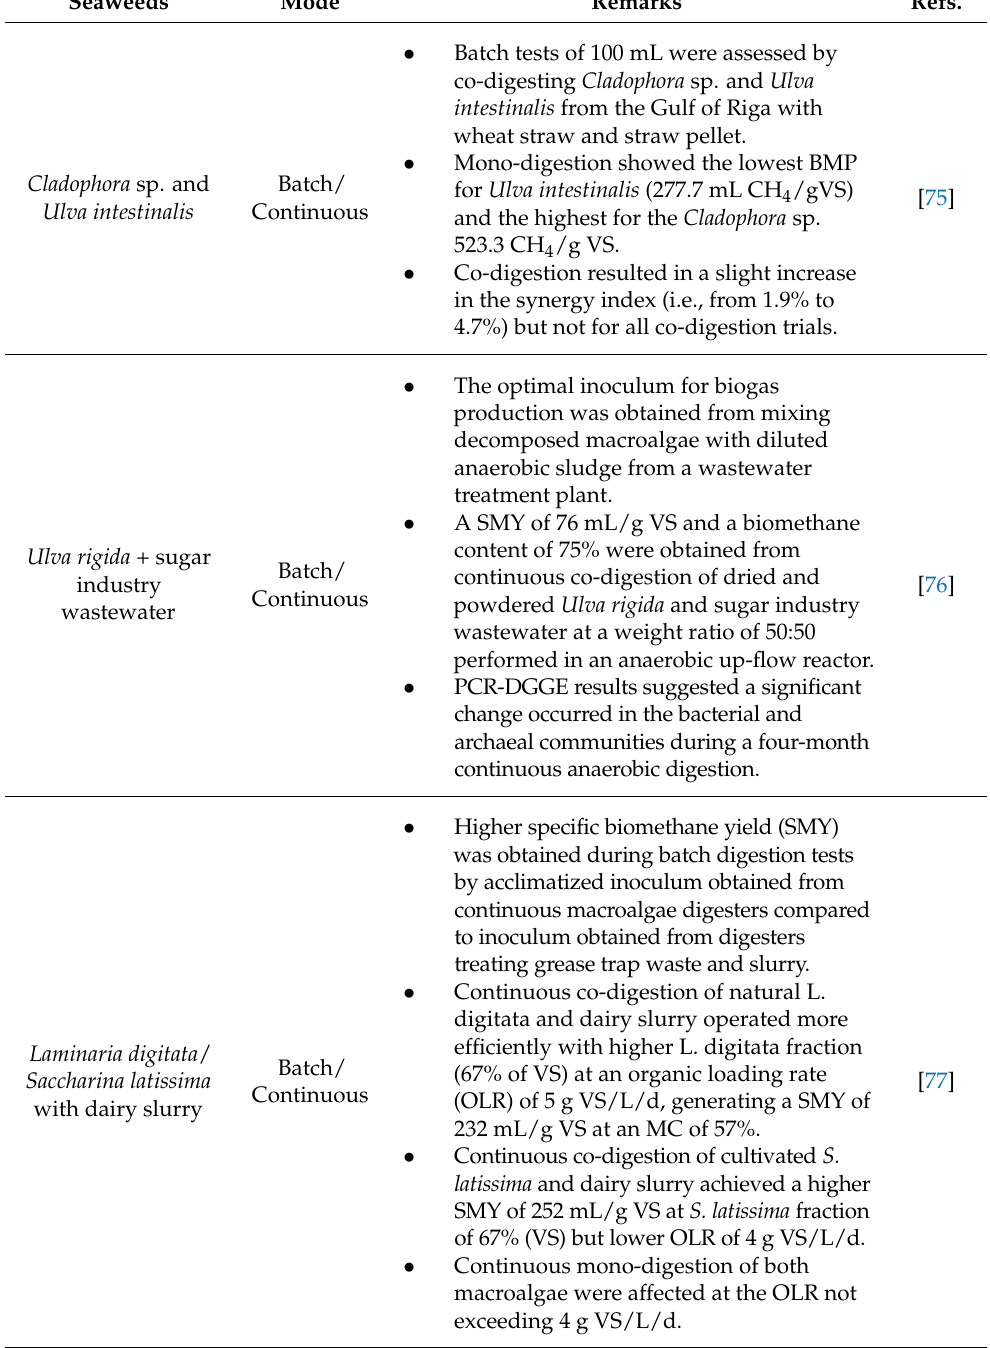
Table 3. Summary of some previous studies that reported anaerobic digestion of